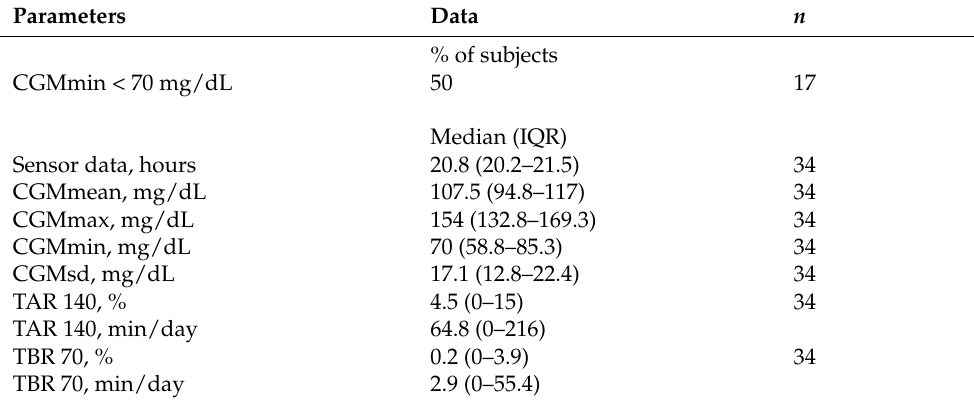
Table 1. CGM metrics within 24 h after OGTT.